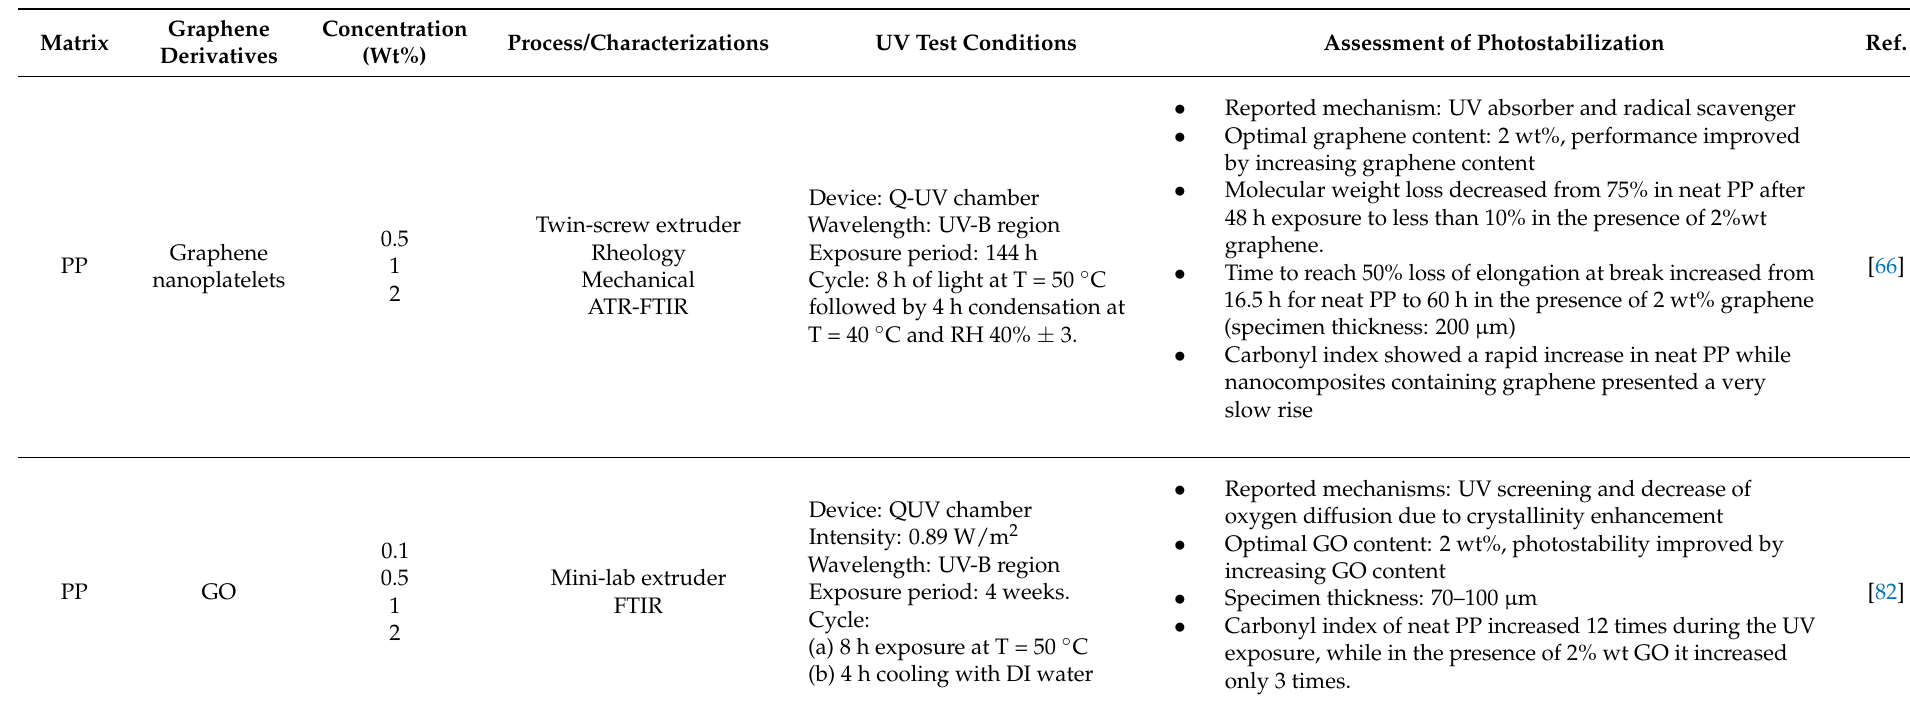
Table 3. Results obtained from photodegradation of polymer/graphene